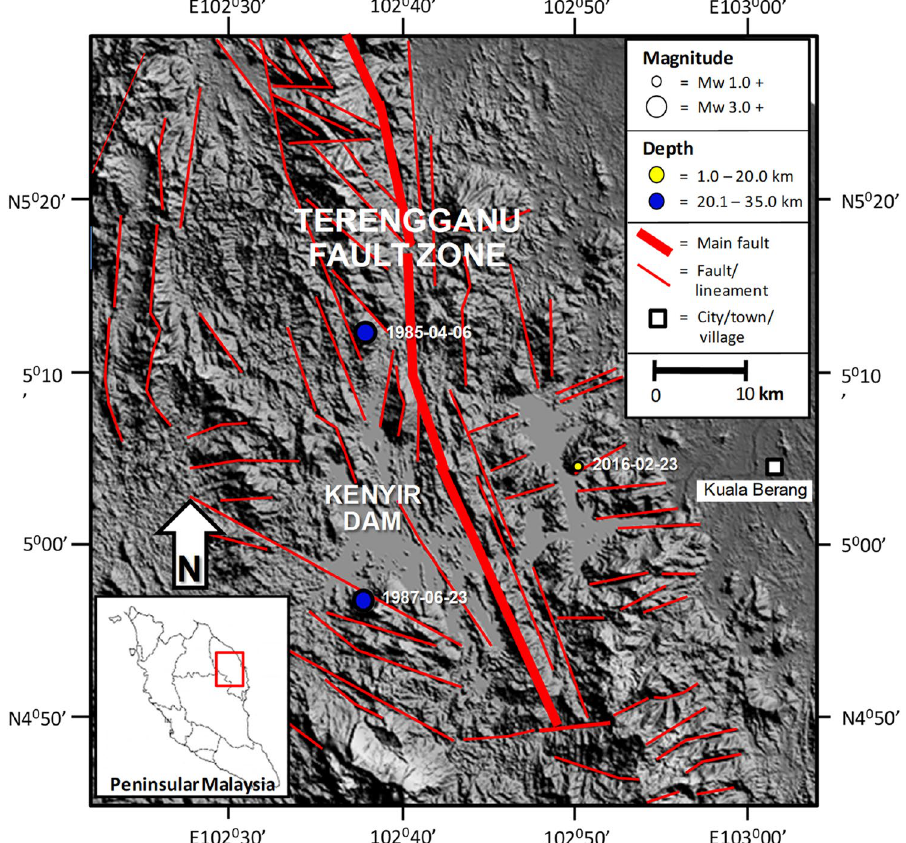
Fig. 9 Epicenters of the local origin earthquakes in the Kenyir Dam area superimposed on the SRTM–DEM image. Red thicker lines indicate known main faults (Terengganu Fault), while red thinner lines are lineaments indicating possible faults. Note: Created with